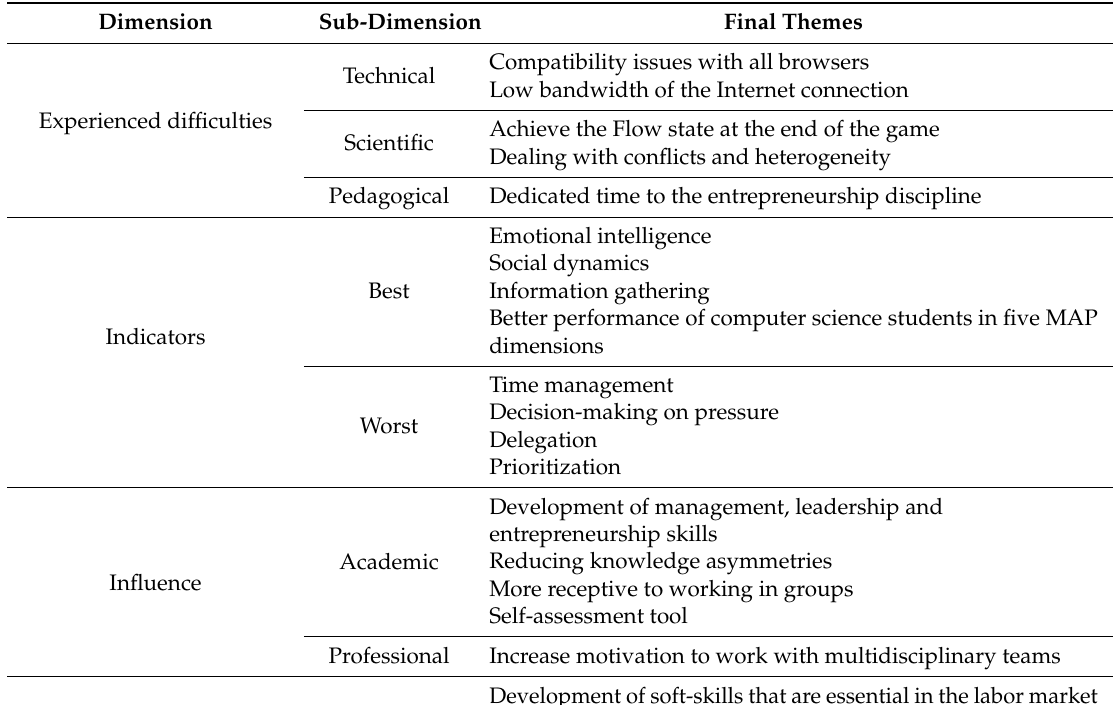
Table 3. Identification of final themes in the thematic analysis process.